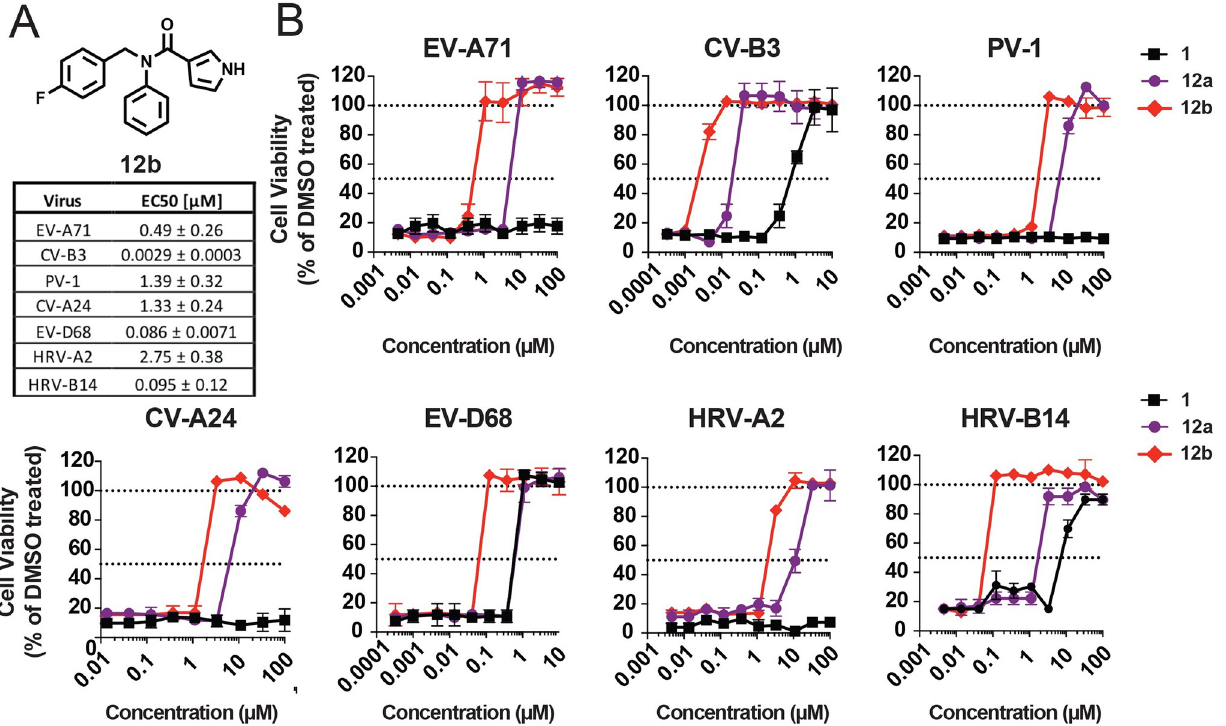
Fig 7. Combination of compound 12a and 19b reveals the most potent broad-spectrum EV and RV inhibitor 12b. (A) The chemical backbone of 12b is shown. The table represents the EC 50 values in μ M ± SD of compound 12b. EC 50 is calculated for the panel of representative EV and RV. EC 50 values represent mean values that are calculated from three independent experiments which were performed in biological triplicates. (B) A multicycle viral replication assay was performed to determine the antiviral activity of compound 12b. HeLa R19 cells were treated with serial dilutions of parental compound 1, the furan amide analogue 12a and 12b. Immediately thereafter, cells were infected with EV-A71 (BrCr), CV-B3 (Nancy), PV-1, CV-A24 (Joseph), EV-D68 (Fermon), HRV-A2, and HRV-B14 at low MOI (depending on the virus, see Material and methods) to reach full CPE within 3 days. Data are shown from one representative experiment out of three independent experiments which were performed in biological triplicate. All underlying experimental data that are displayed can be found in S2 Data. CPE, cytopathic effect; CV, coxsackievirus; EC 50 , 50% effective concentration; EV, enterovirus; HRV, human rhinovirus; PV, poliovirus; RV,